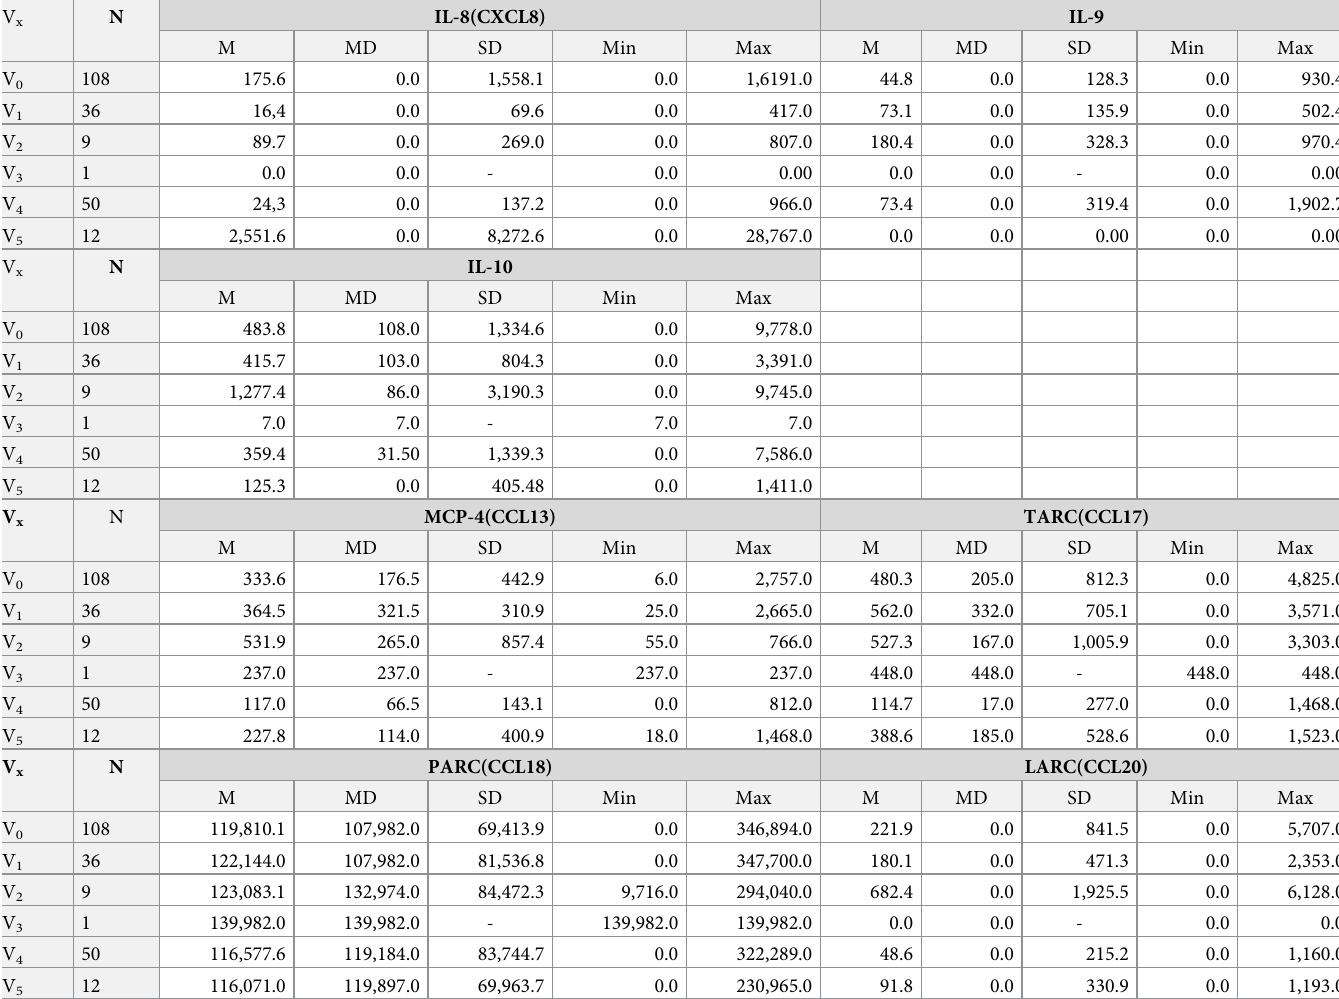
Table 6. Levels of cytokines and chemokines over time. Cytokines IL-8(CXCL8), IL-9, IL-10 and chemokines MCP-4(CCL13), TARC(CCL17), PARC(CCL18) and LARC(CCL20) were quantified in pg/ml in AE patients over time. Vx = follow-up visit with V0 = baseline, N = number, M = mean, SD = standard deviation; Min. = mini- mum, Max. =